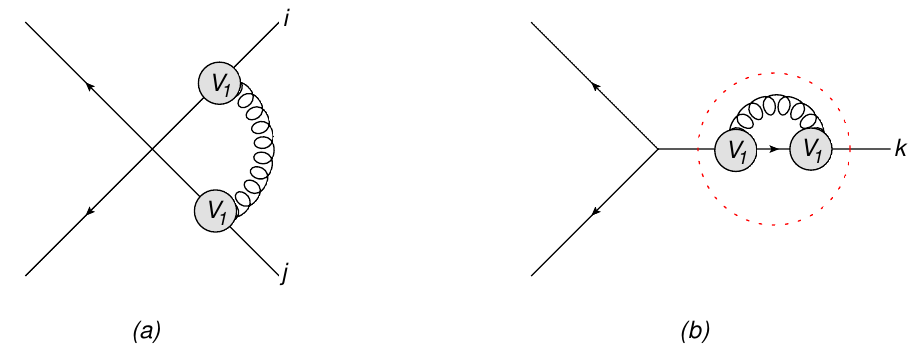
Figure 12 . ( a ) The (1,1) web, which features a 1-gluon emission vertex on each line; ( b ) collinear reduction of Wilson lines i and j to make a self-energy web on the single line i